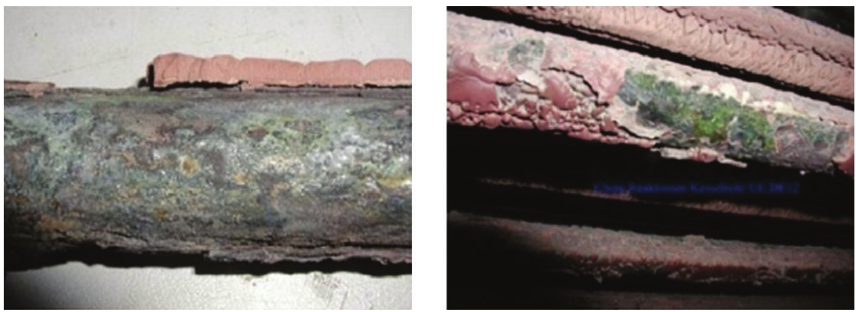
Figure 1: Corrosion with high chlorine biomass cofiring